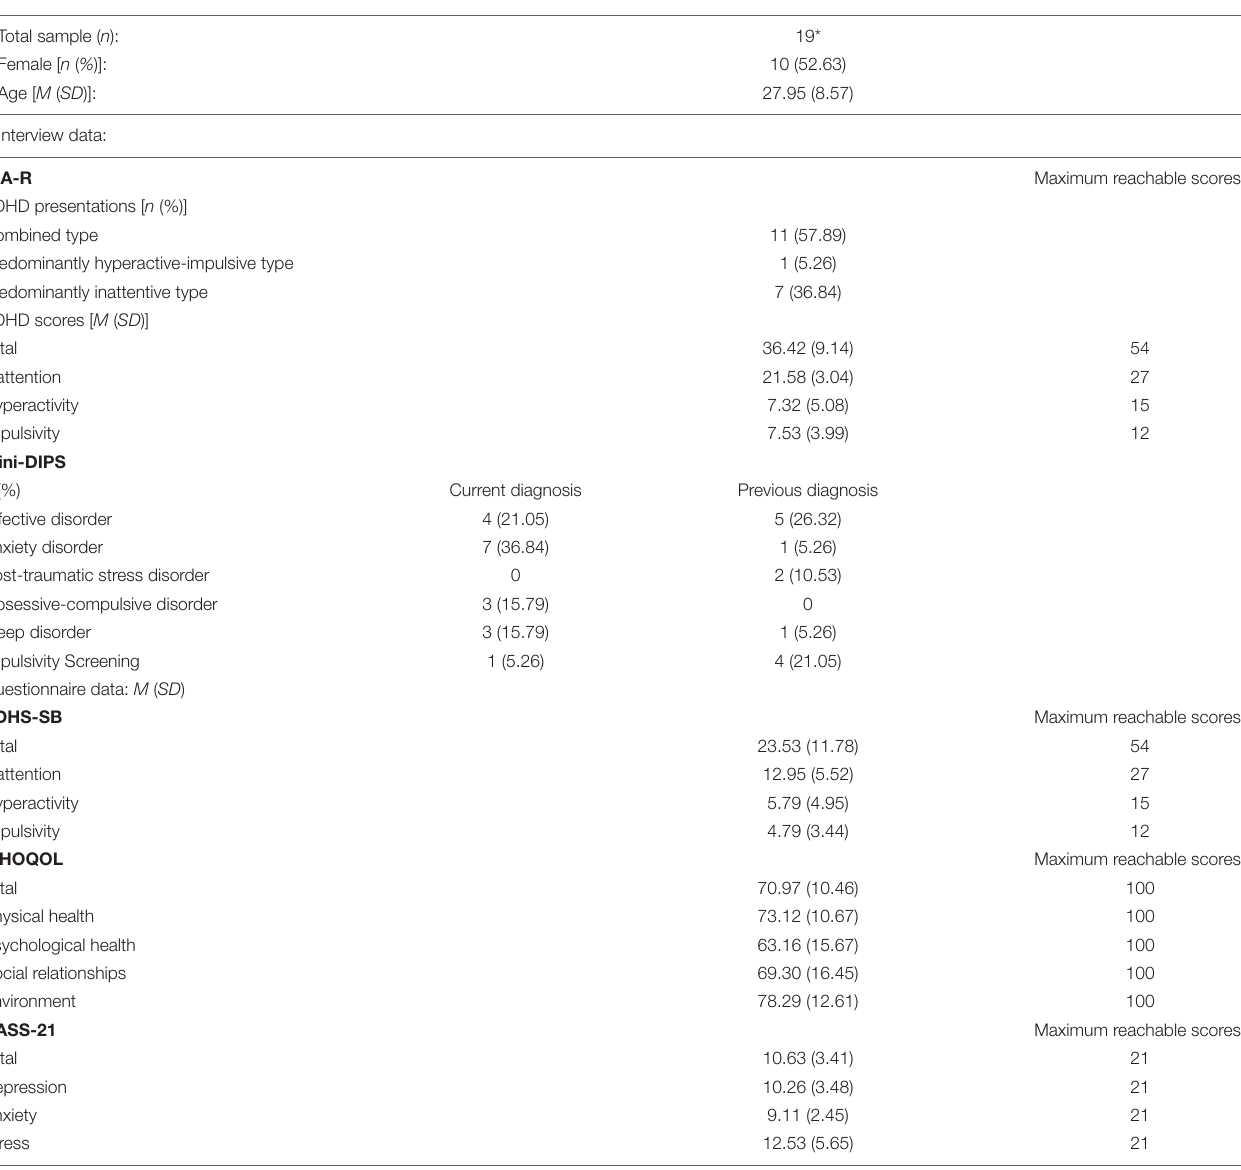
TABLE 1 | Sociodemographic and clinical sample